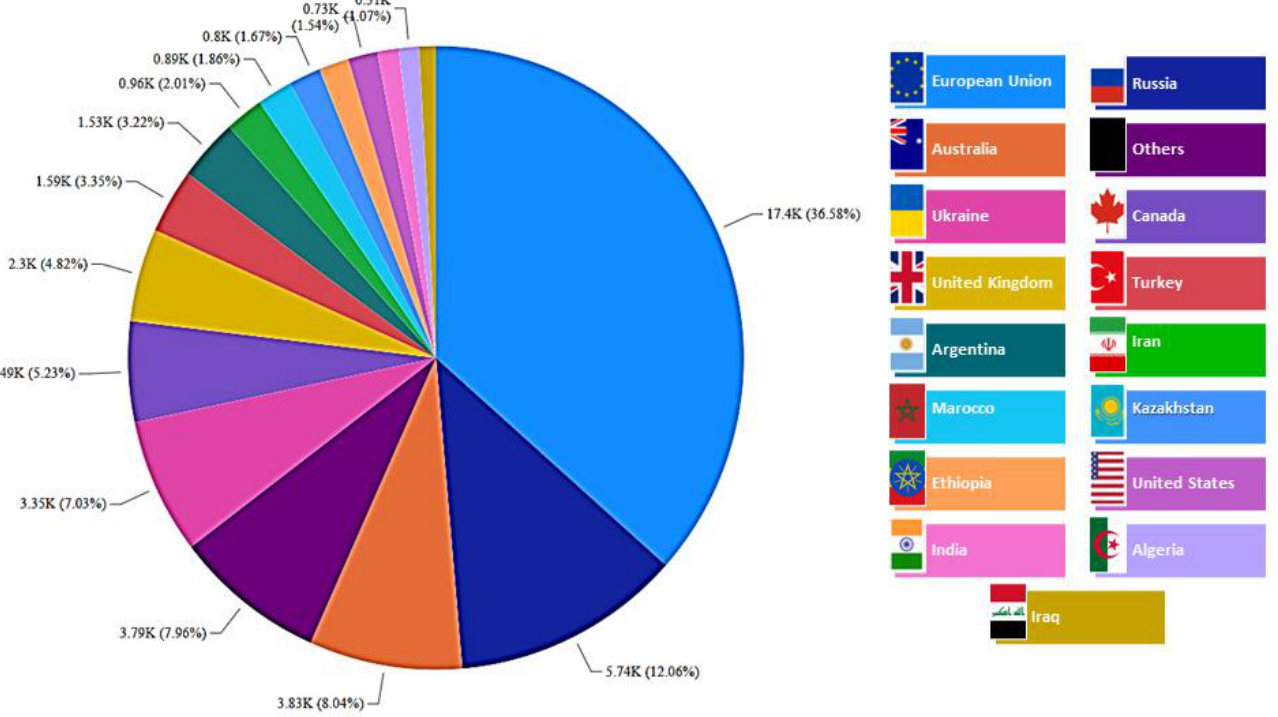
Figure 12. Main barley-producing countries in 2020 (thousand metric tons).